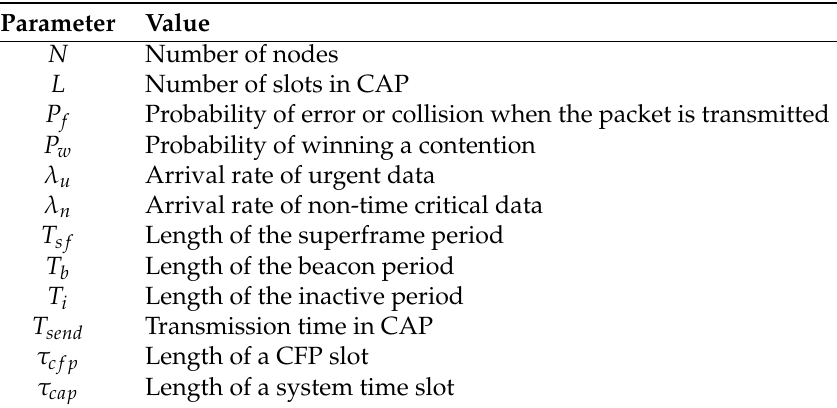
Table 1. Theoretical approach